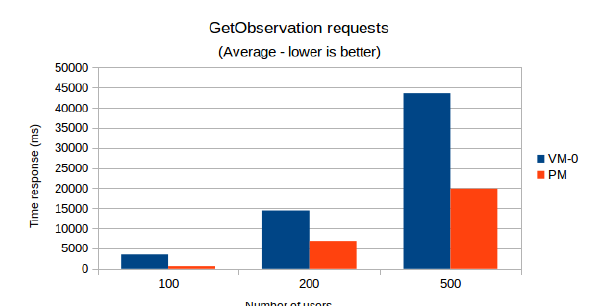
Figure 11. Median response time in milliseconds for the GetObservation request with 100, 200 and 500 concurrent users both for the VM-0 and PM.